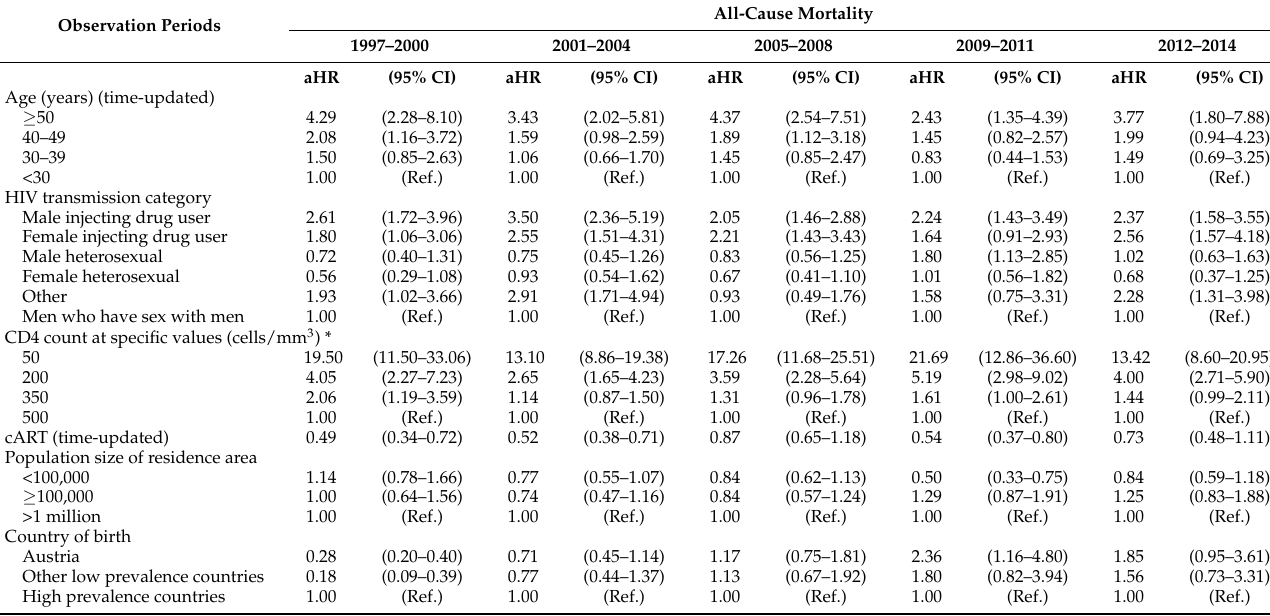
Table 3. Factors associated with all-cause mortality in different calendar time periods: Results from multivariable Cox regression models.